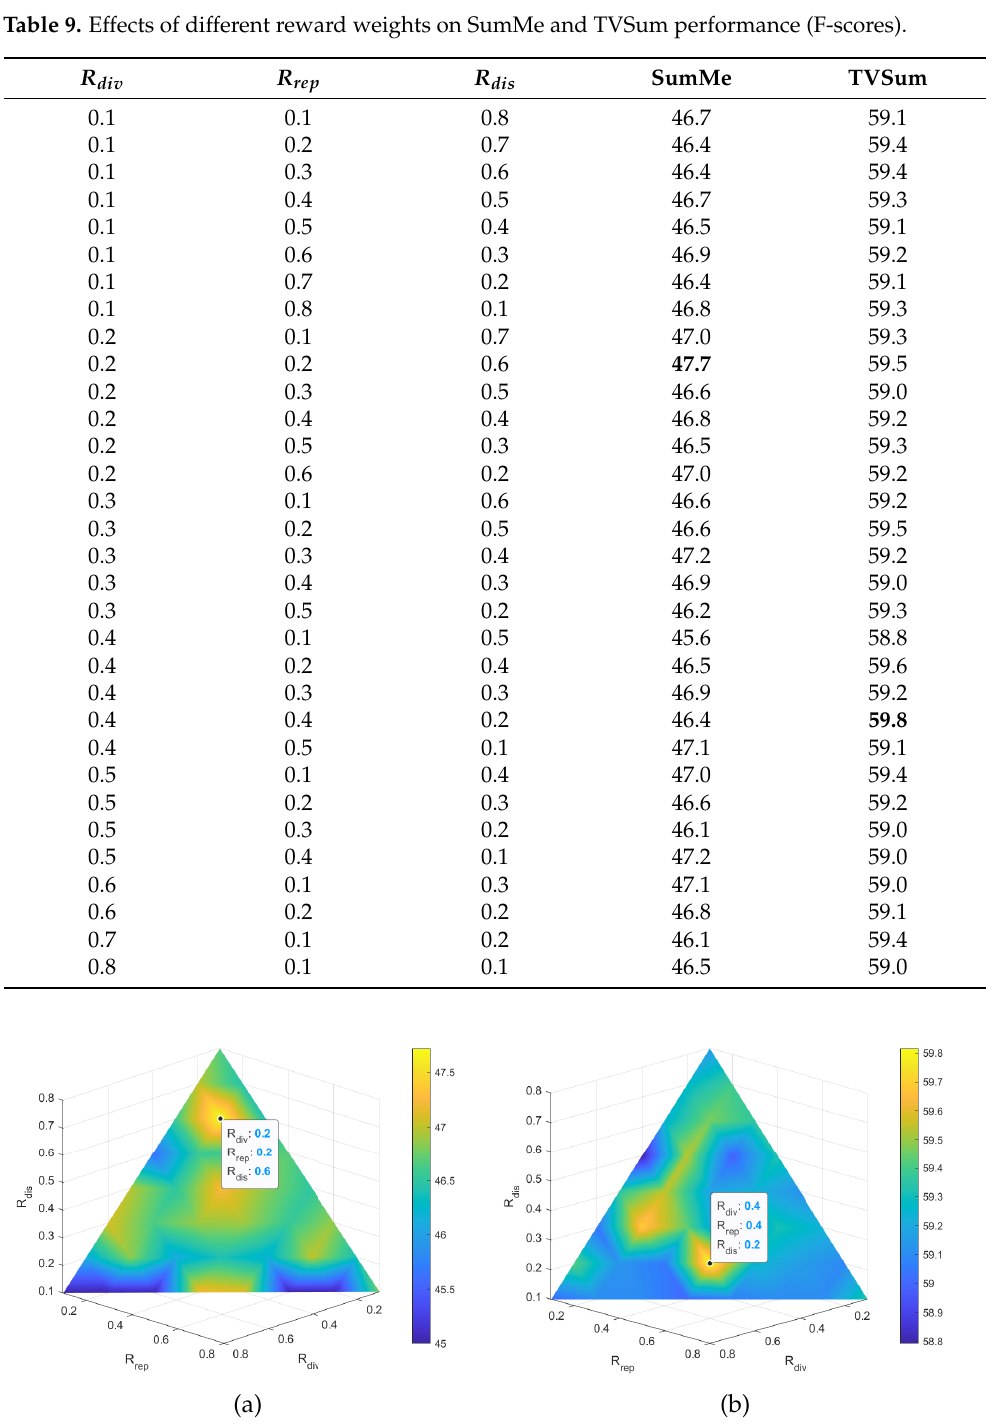
Figure 9. Effects of different reward weights on SumMe and TVSum performances (F score): ( a ) SumMe dataset and ( b ) TVSum dataset. The three axes correspond to the weights of the three reward functions and the depth of the colors represents the F scores. Table 10. Weights that yield the best performances for the reward functions on both